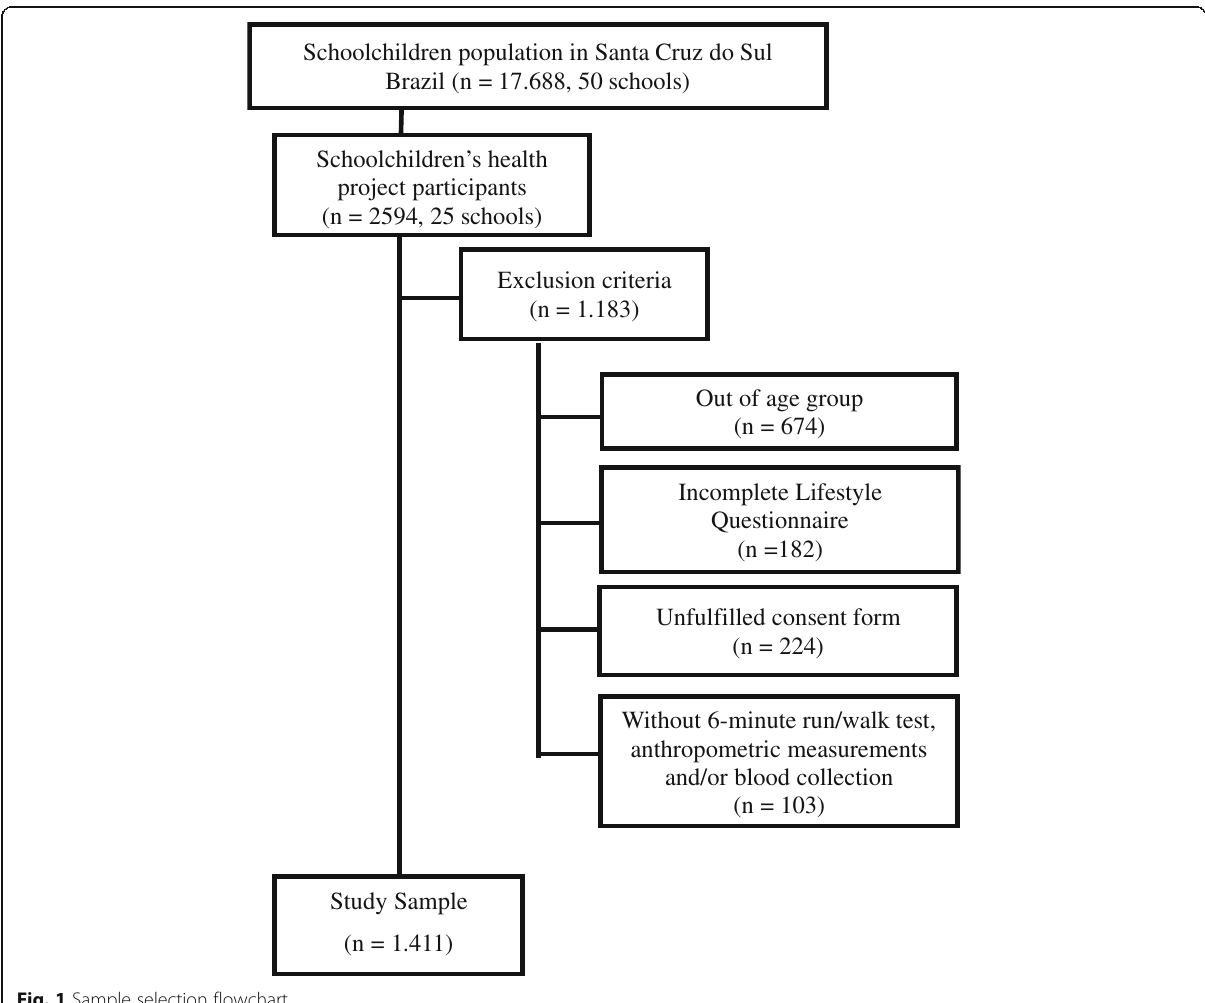
Fig. 1 Sample selection